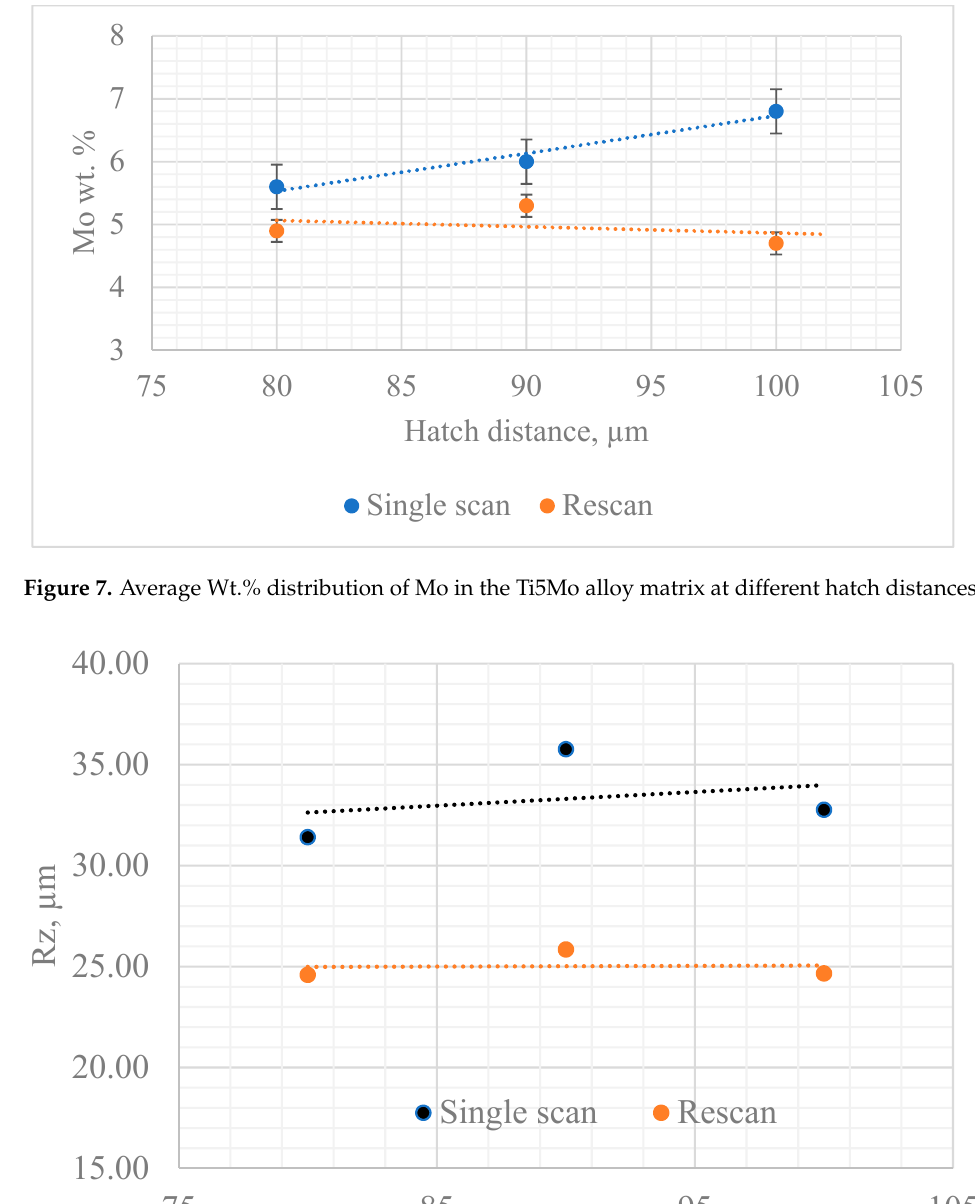
Figure 7. Average Wt.% distribution of Mo in the Ti5Mo alloy matrix at different hatch distances.